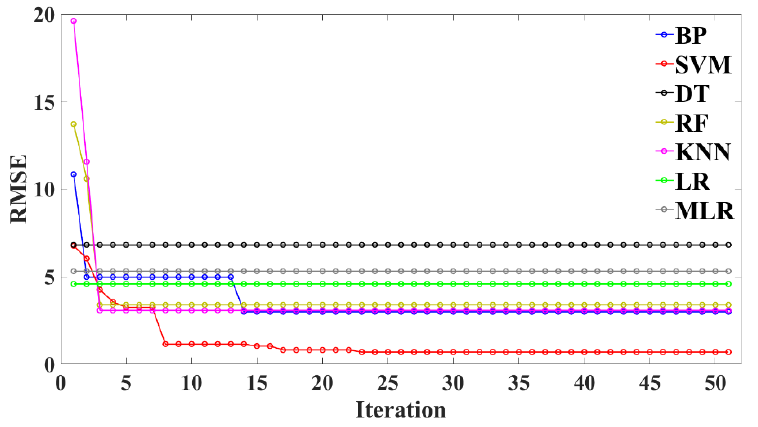
Figure 7. The relationship between RSME values and the number of iterations of different models.